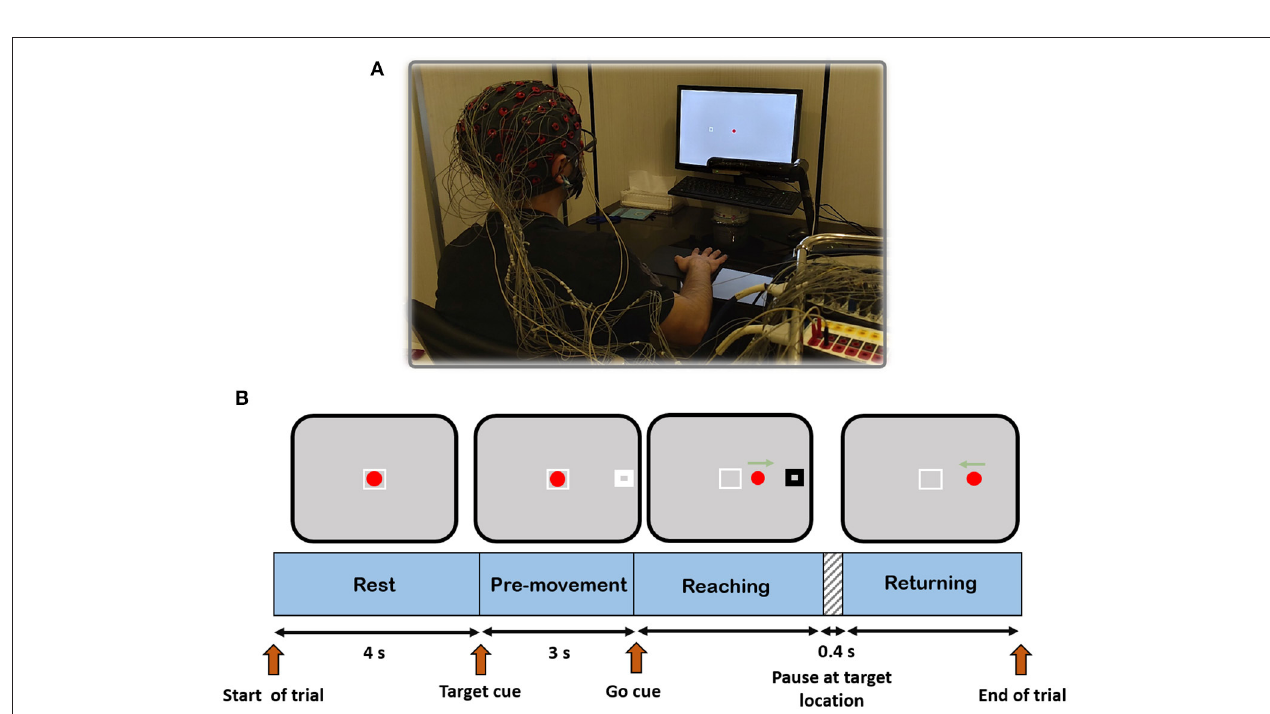
FIGURE 2 | (A) Experimental setup showing a subject performing the task. (B) Task protocol timeline.